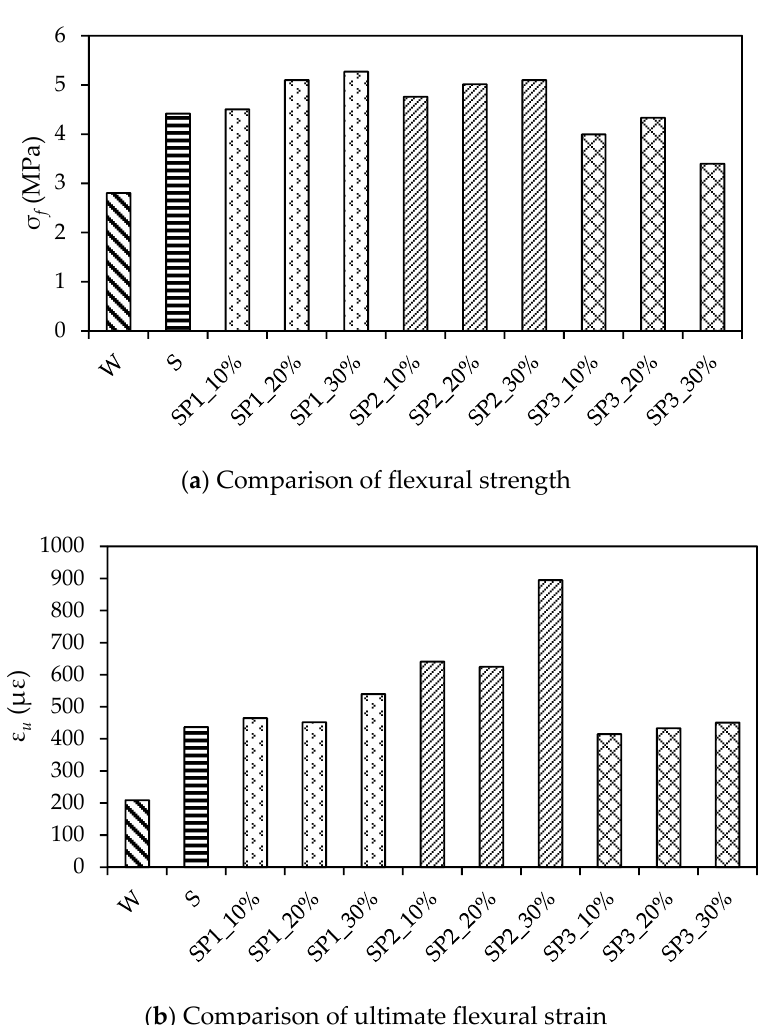
Figure 7. Comparison of compressive test results.